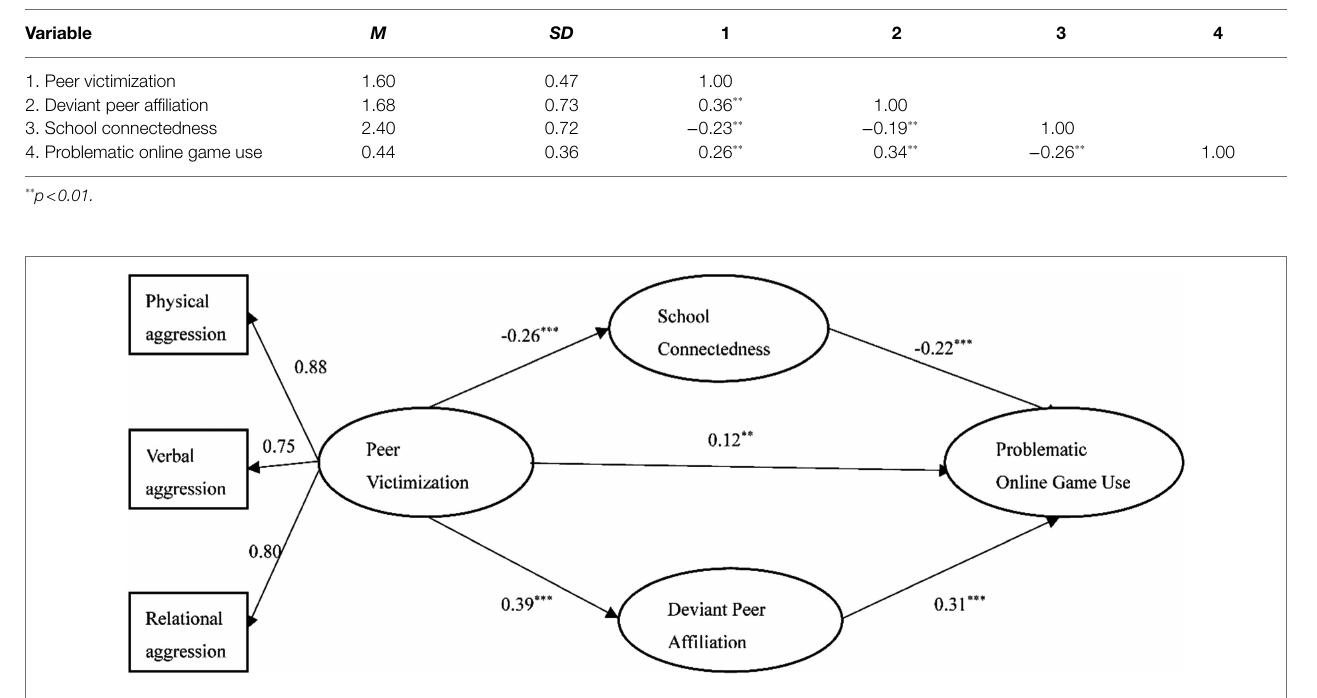
FIGURE 1 | Path model results with standardized coefficients ( n = 698). *** p < 0.001, ** p < 0.01. than that of girls ( M boys = 0.57, M girls = 0.30, t = 10.92, p < 0.001).